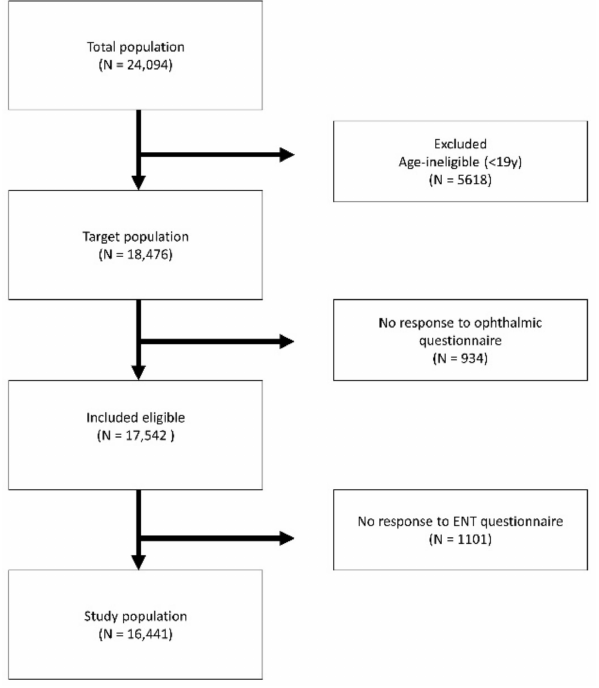
Figure 1. Flowchart of the study population KHANES V.